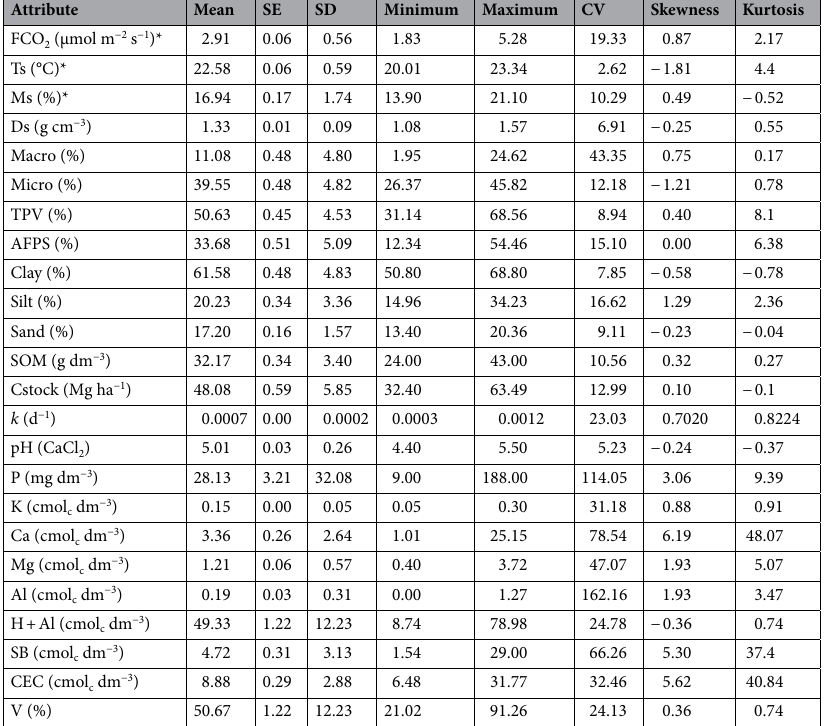
Table 2. Descriptive statistics of soil physical and chemical attributes assessed in the sugarcane field reform area. N = 100, except for *, in which N = 900. SE standard error of the mean, SD standard deviation,